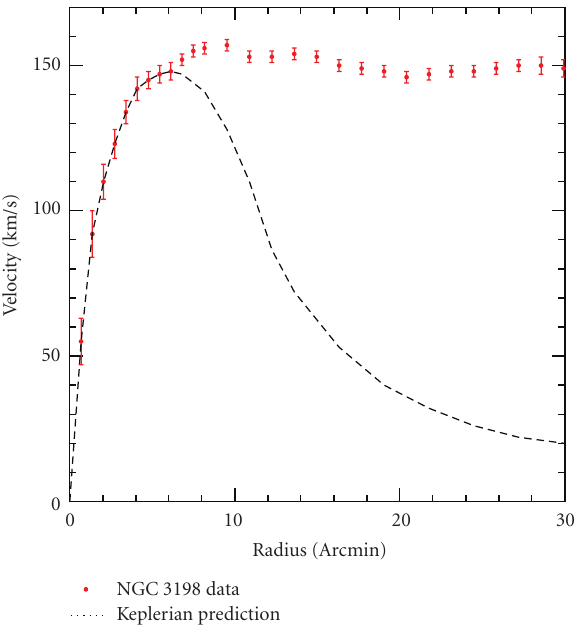
Figure 1: Measured rotational velocities of HI regions in NGC 3198 [5] compared to an idealized Keplerian behavior.